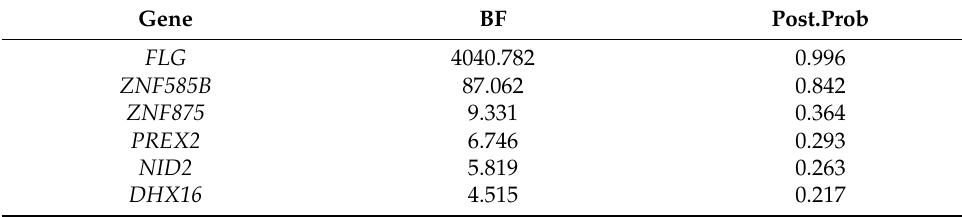
Table 2. The results of RAVIS analysis by using